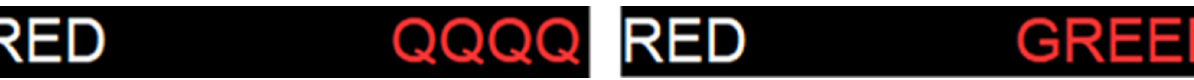
Fig 1. Two example stimulus displays of the Stroop Matching Task (not to scale). The task is to decide whether the probe stimulus (the left stimulus) matches the target stimulus (the right stimulus). In neutral match trials (displayed in the left panel), the target is a meaningless letter string (QQQQ) printed in the same color as the probe (red). In incongruent match trials (displayed in the right panel), the target stimulus names a color (GREEN) that is different from the printed color (red). The difference in performance between the incongruent and the neutral match trials is used to compute the Stoop Matching